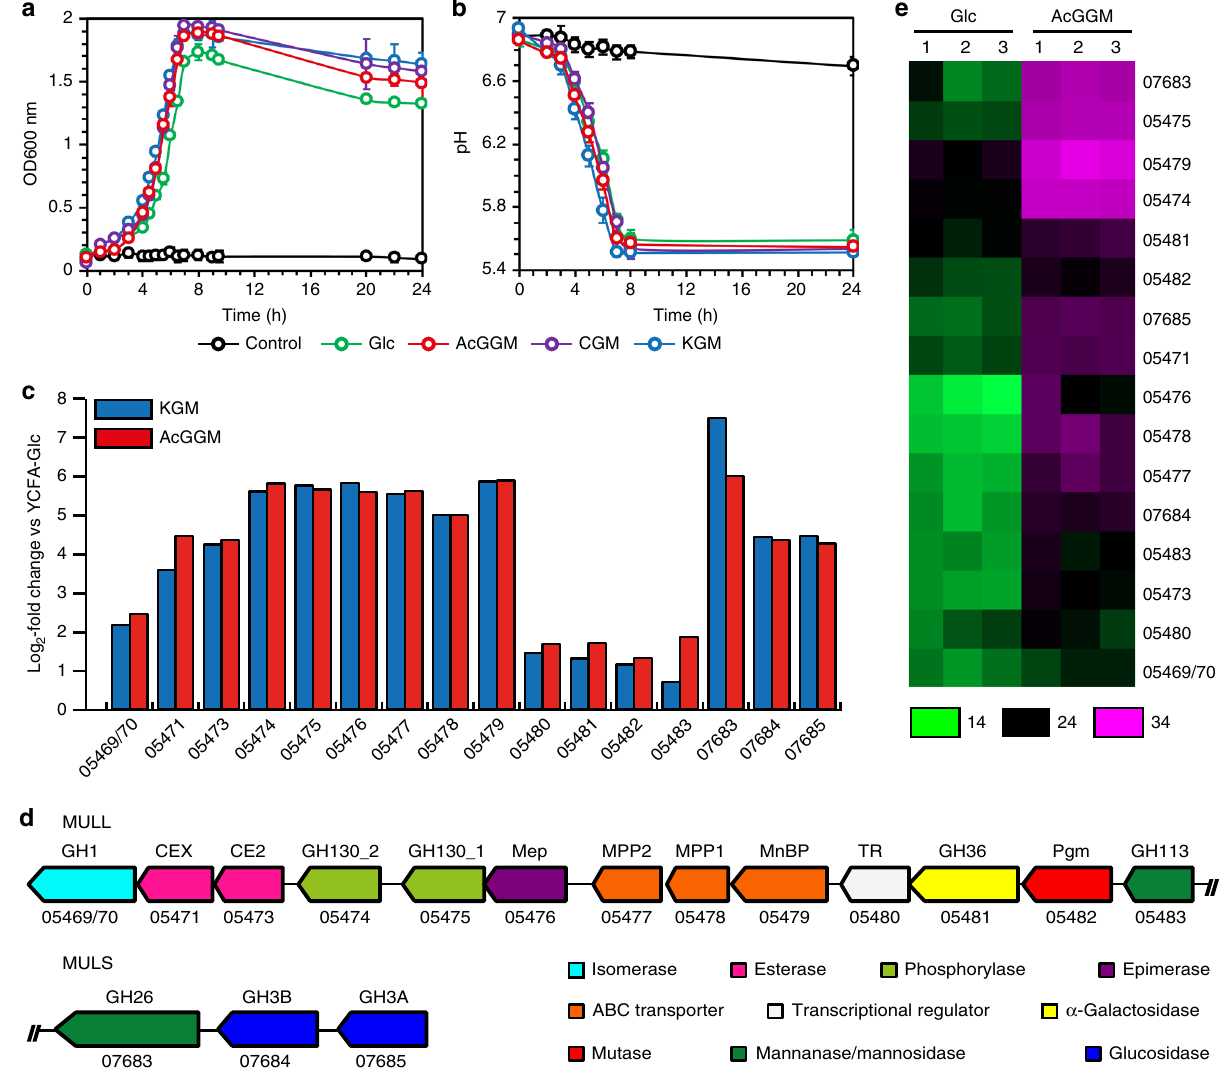
Fig. 2 R. intestinalis upregulates several glycoside hydrolases, two carbohydrate esterases and an ABC-transporter during β -mannan consumption. a Growth curves of R. intestinalis in YCFA without carbon source (black) or supplemented with 0.5% of either glucose (Glc, green circles), KGM (blue circles), CGM (purple circles) or AcGGM (red circles). b pH measurements during R. intestinalis growth on Glc and β -mannans. In a and b , each point on the curves represent the average of three independent experiments. Error bars represent standard deviations (s.d.). c RNA expression pro fi le of putative β -mannan utilization genes during R. intestinalis L1 – 82 growth in YCFA supplemented with 0.5% KGM (blue bars) or AcGGM (red bars). The Log 2 -fold change relative to cells cultured on YCFA-Glc is shown on the y -axis while the x -axis shows the putative genes involved in β -mannan catabolism. d Genomic organization of the large and small β -mannan utilization loci (MULL and MULS, respectively) from R. intestinalis . Genes with similar predicted functions are coded by the same color. e Heat map showing the proteomic detection of relevant proteins with predicted β -mannan utilization functions in triplicate samples (1 − 3) grown on YCFA-Glc and YCFA-AcGGM. Colors represent protein intensity expressed as Log 2 of LFQ values; the color gradient ranges from 14 (green) to 34 (magenta), with black indicating 24. In c – e , locus tag numbers ROSINTL182_XXXXX are abbreviated with the last numbers after the